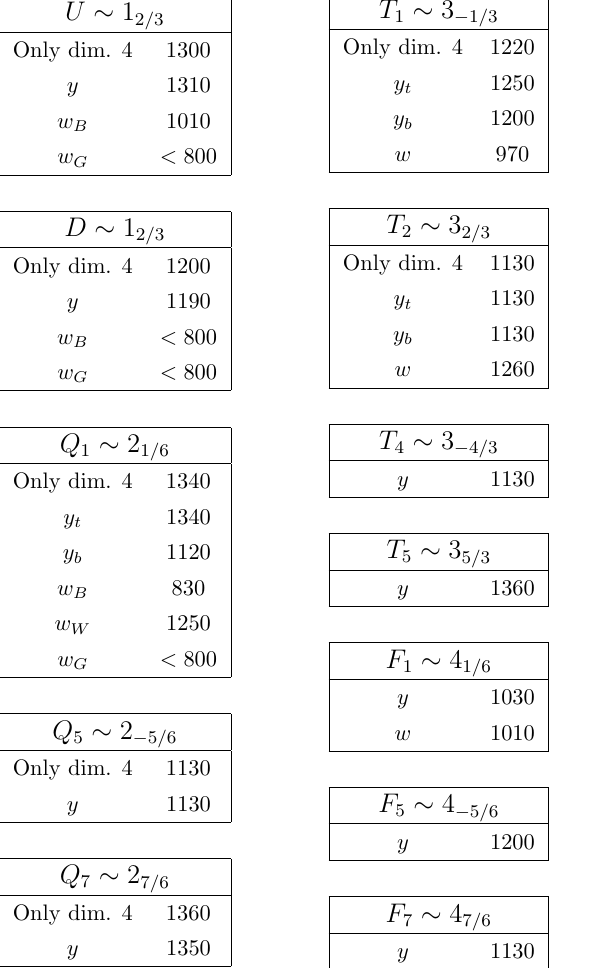
Table 7 . Mass limits for each multiplet and di(cid:11)erent values of the couplings. In the right column, a lower bound on the mass of the heavy quark (in TeV) is displayed, assuming that the corre- sponding coupling in the left column has a value of (2 TeV) (cid:0) 1 and the other dimensionful couplings vanish. The dimensionless couplings (cid:21) are always chosen to saturate the corresponding electroweak precision